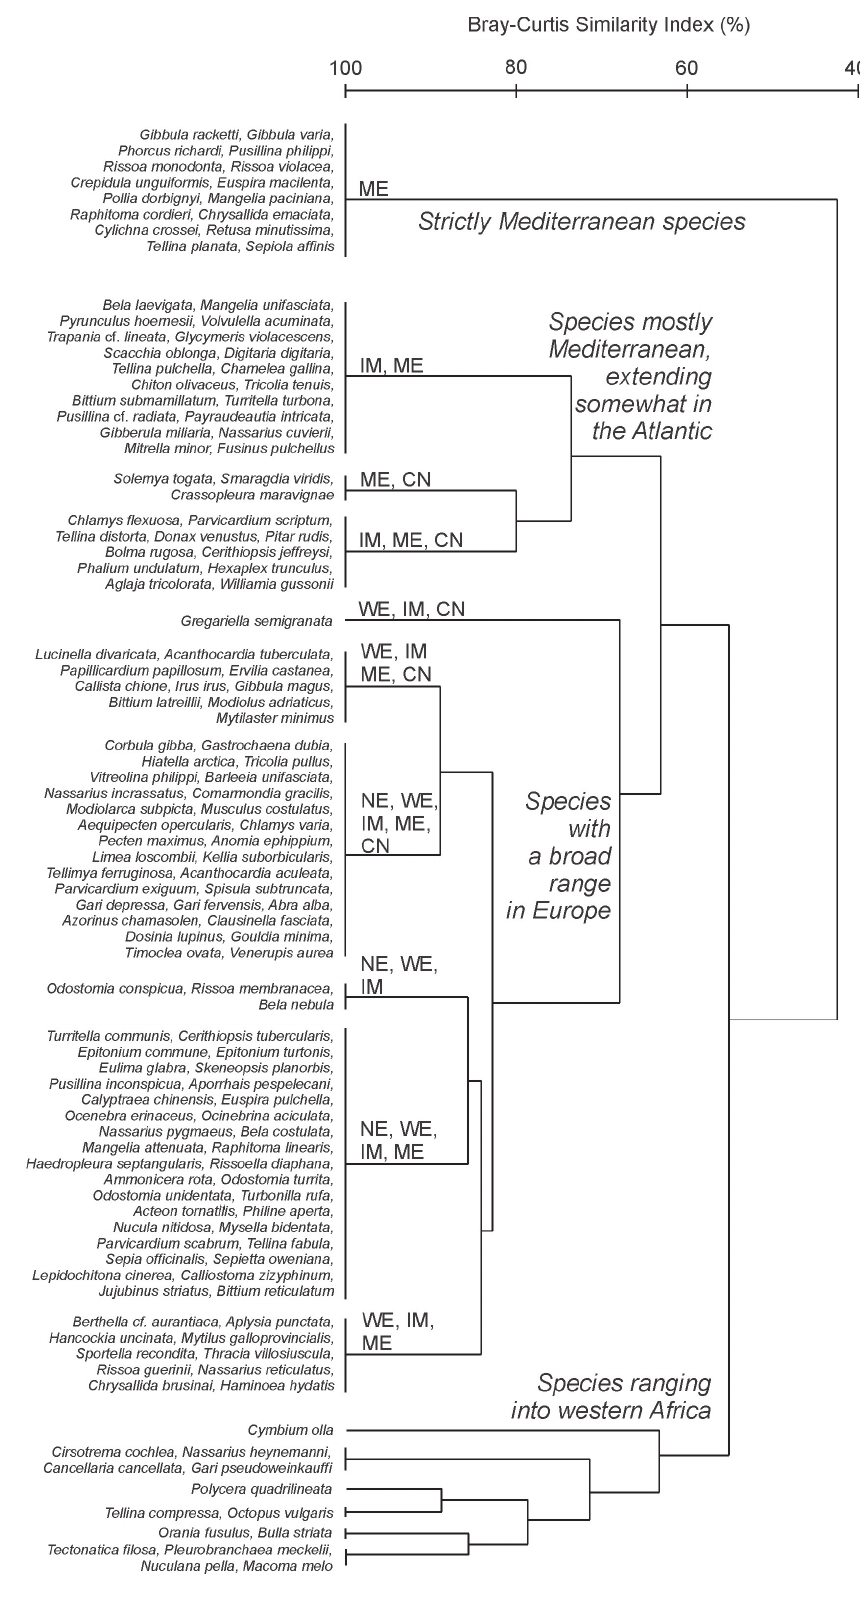
Fig . 8. – Cluster displaying faunistic groupings in relation to their presence in different geographical sectors using qualitative data (presence/ absence) and the Bray-Curtis similarity index. Codes are listed in Table